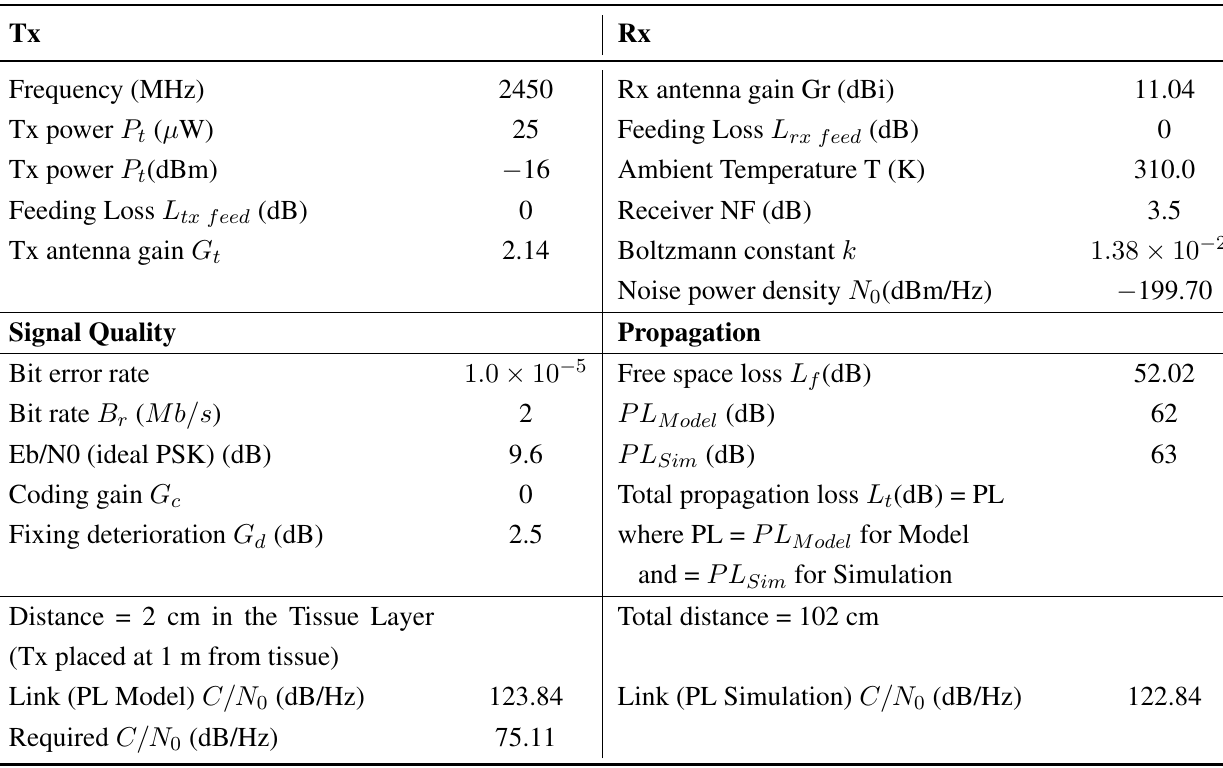
Table 4. Parameter values: Link budget calculation for a distance of 102 cm of separation between the Tx and the